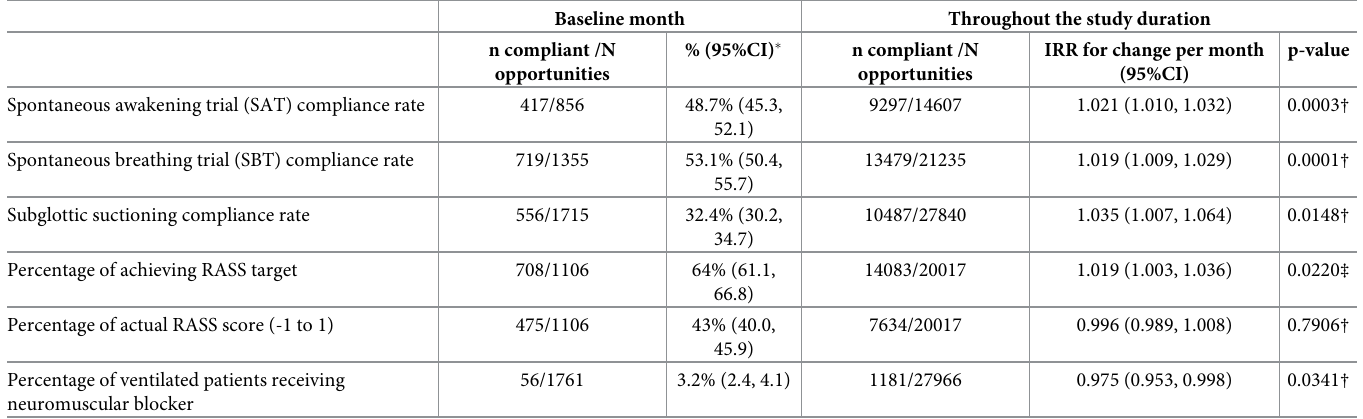
Table 1. Daily care process